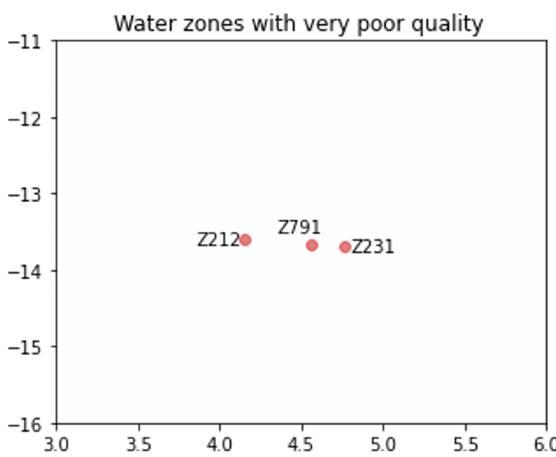
Figure 9. Water zones with very poor